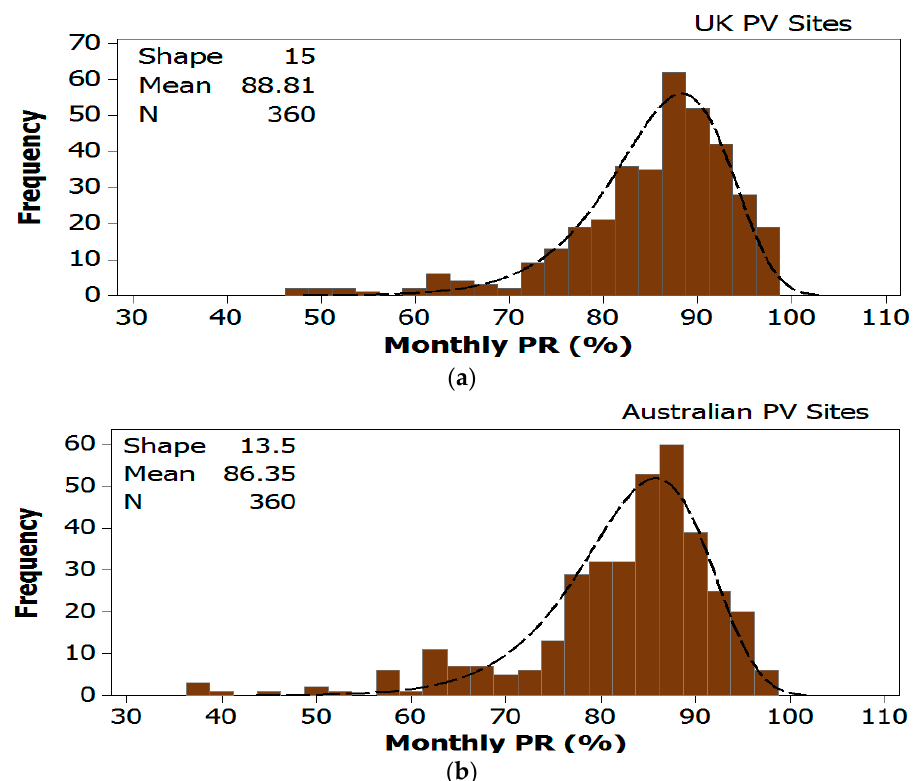
Figure 9. Monthly performance ratio analysis for all examined PV systems for a period of 10 years: ( a ) UK PV sites; ( b ) Australian PV sites.